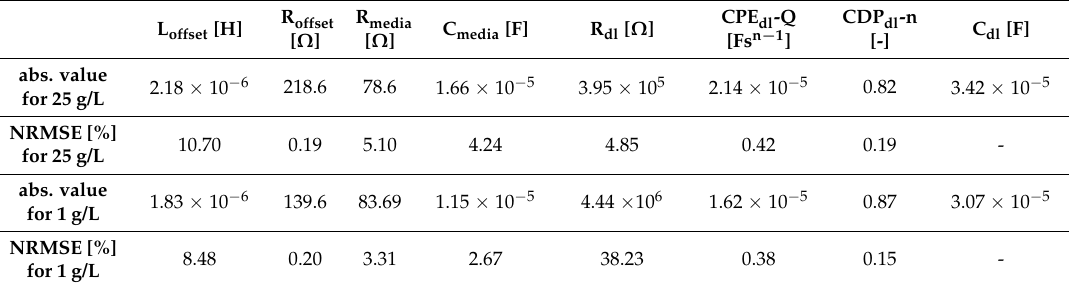
Table 1. Fitting results of CNLS fit given in Figure 2B with corresponding error estimations (Chi